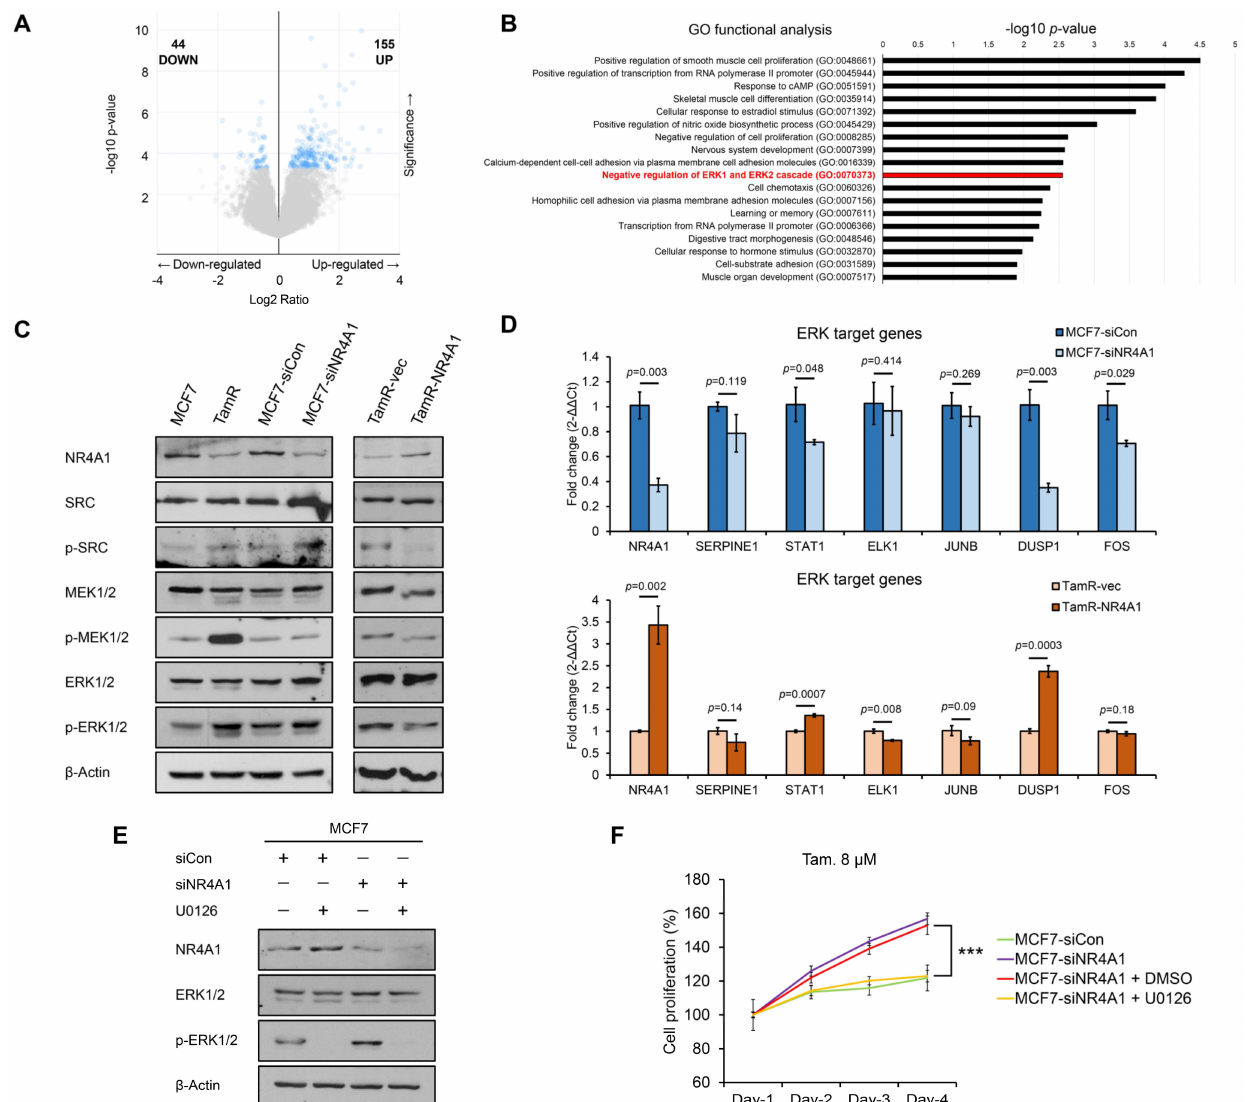
Figure 4. NR4A1 alters tamoxifen sensitivity in ER-positive breast cancer cells by suppressing the ERK signaling pathway. ( A ) The volcano plot of significantly up- and down-regulated genes according to mRNA expression profile of NR4A1 gene (Student’s t -test p < 0.05 and Benjamini-Hochberg procedure q < 0.05). ( B ) Gene ontology functional enrichment analysis showing biological processes enriched in 199 genes regulated by NR4A1. ( C ) Western blot analysis of ERK signaling pathway-related protein in MCF7, TamR, MCF7 cells transfected with scramble (negative) control (siCon), NR4A1 siRNA (siNR4A1), and TamR cells transfected with pcDNA3 and pcDNA3-NR4A1. ( D ) mRNA expression levels of ERK target genes in MCF7 cells transfected with scramble (negative) control (siCon) and NR4A1 siRNA (siNR4A1), and TamR cells transfected with pcDNA3 and pcDNA3-NR4A1. ( E ) Western blot analysis of NR4A1, ERK1/2, and p-ERK1/2 proteins in MCF7-siCon and siNR4A1 cells following treatment with U0126 or DMSO (control) ( F ) Cell proliferation curves of MCF7-siCon and siNR4A1 cells treated with U0126 or DMSO (control) under the presence of 8 µ M tamoxifen (Tam.) for 4 days. *** p <